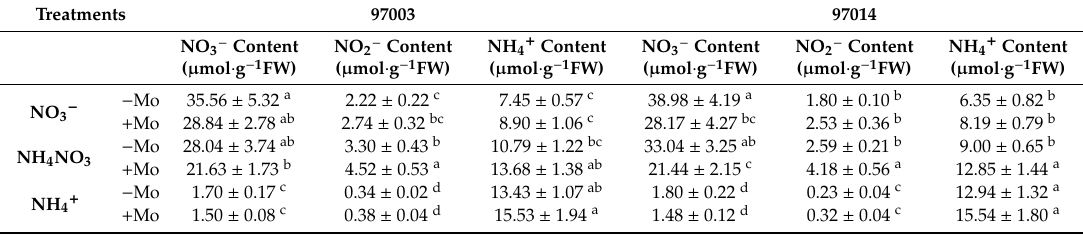
Note: − Mo and + Mo represent winter wheat cultivars fertilized, respectively, with 0 and 1 µ M Mo [Na 2 MoO 4 .2H 2 O] against di ff erent N sources. Data represent means ± S.E from di ff erent independent treatments. Dissimilar superscripted letters (a, b, c, etc.) in each column indicate significant di ff erences among di ff